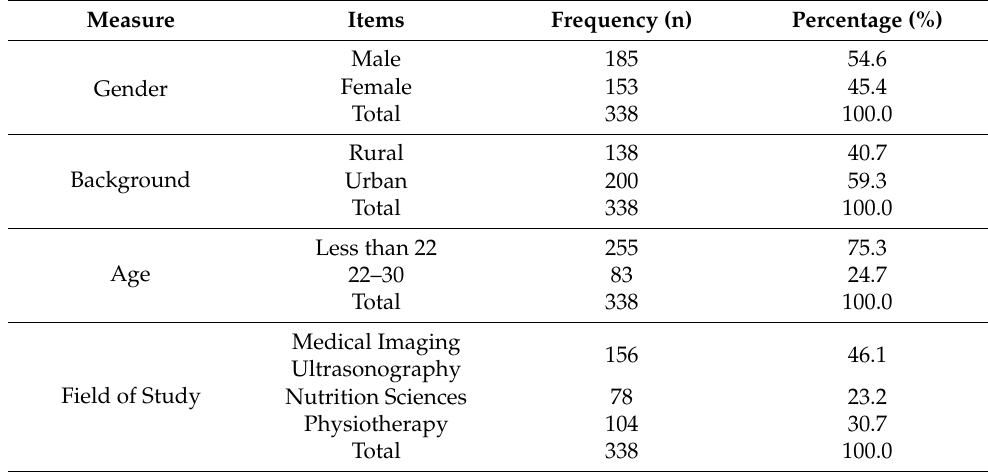
Table 3. Demographics profile of the participants.